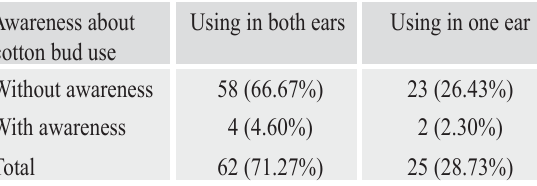
Table II: Association between awareness about the effects of cotton bud and habit of cotton